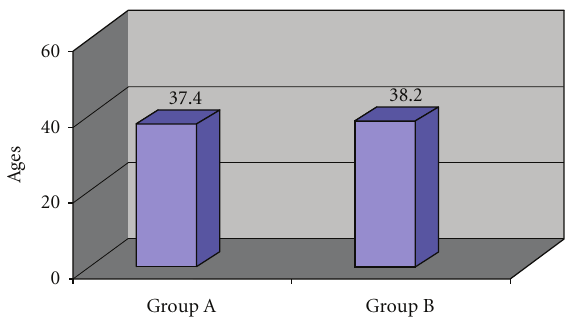
Figure 4: Comparison of the ages of the two groups.